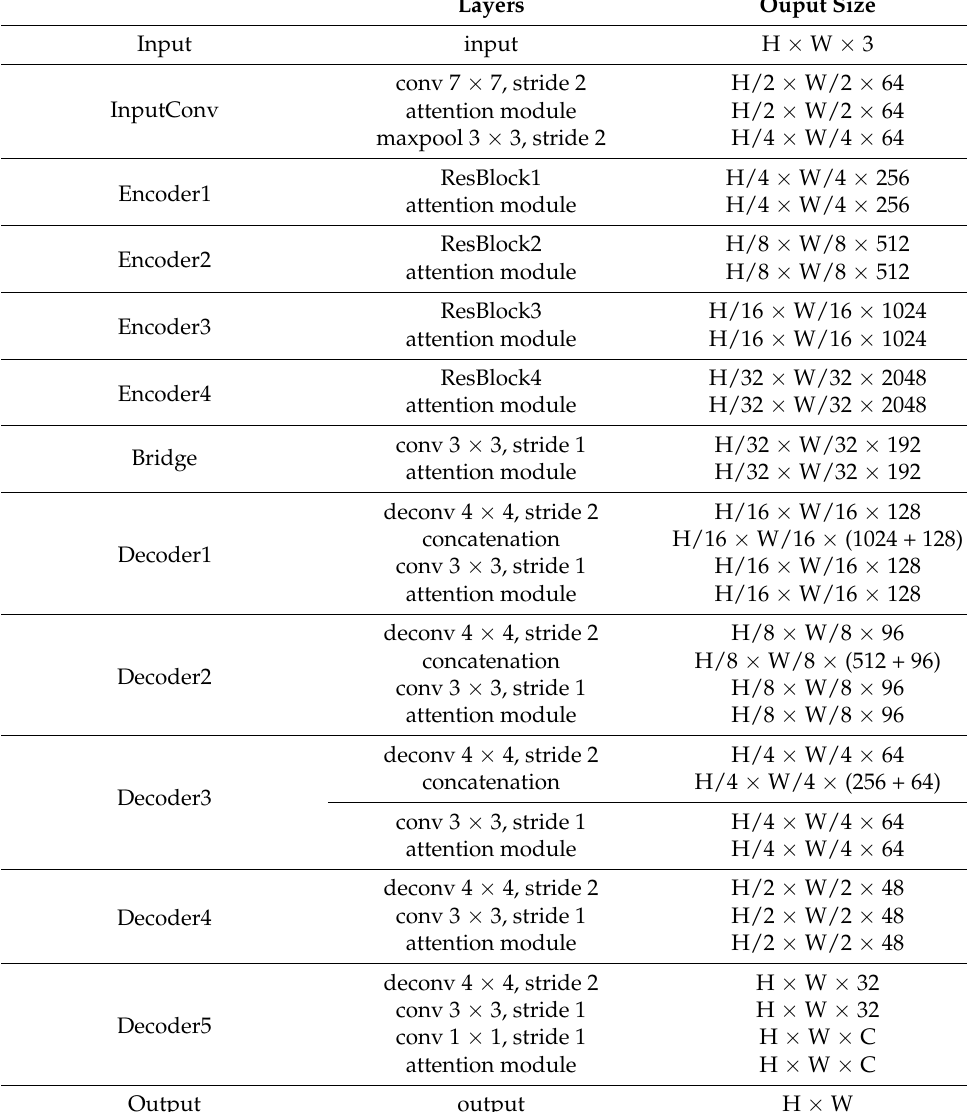
Table 3. The network structure of